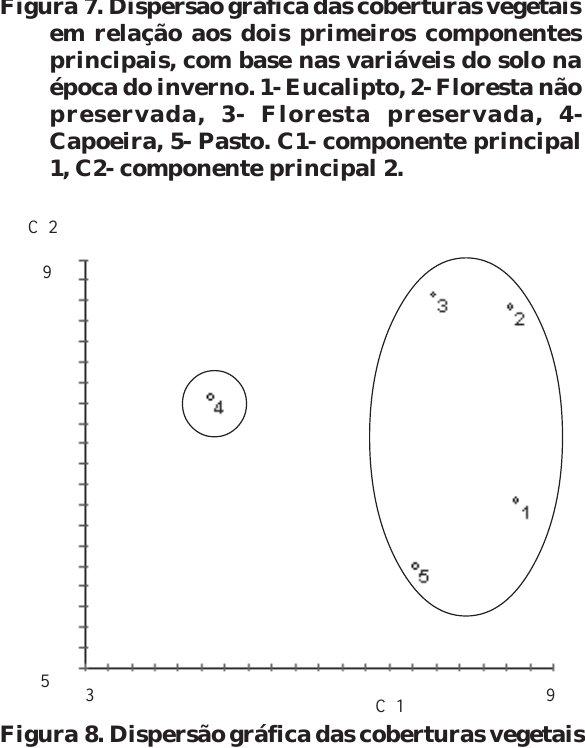
Figura 8. Dispersão gráfica das coberturas vegetais em relação aos dois primeiros componentes principais, com base nas variáveis da serapilheira na época do inverno. 1- Eucalipto, 2- Floresta não preservada, 3- Floresta preser- vada, 4- Capoeira, 5- Pasto. C1- componente prin- cipal 1, C2- componente principal 2.